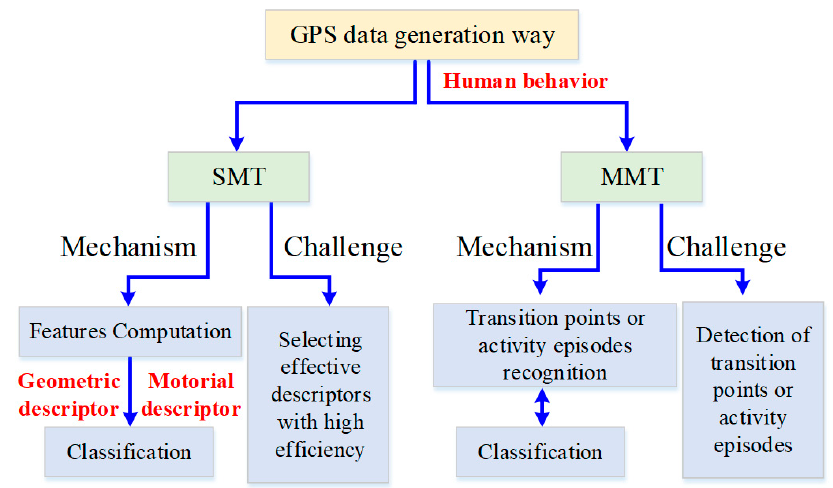
Figure 3. Overview of GPS data classification based on the transportation mode.